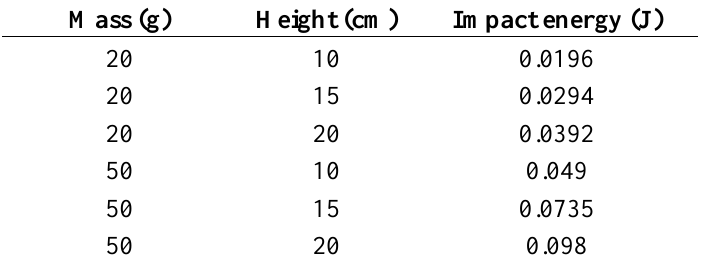
Table 1. The approximate impact